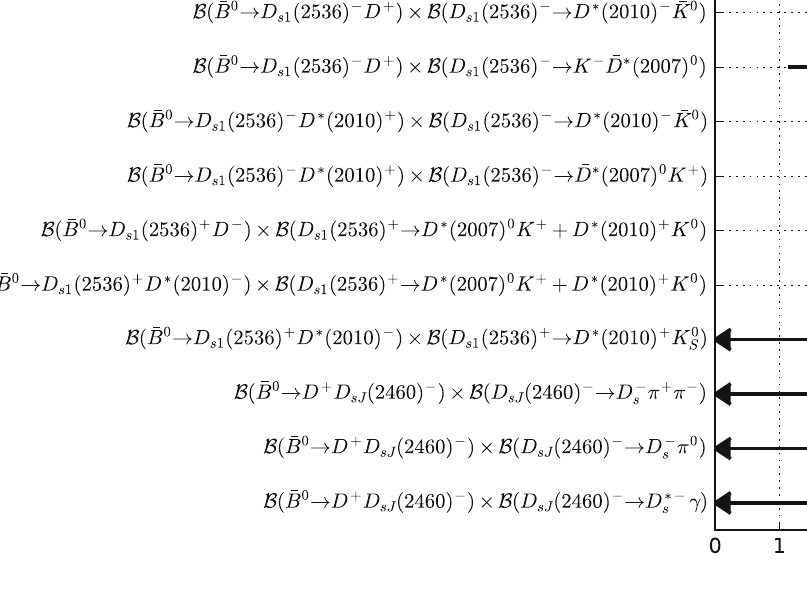
Fig. 89 Summary of the averages from Table 115